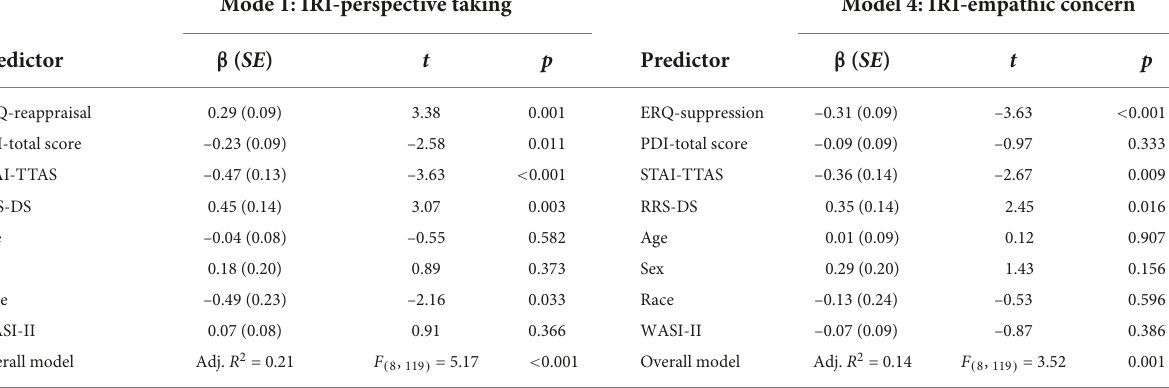
TABLE 3 Subset of linear models testing effects of emotion regulation strategies and delusion-proneness on empathic tendencies. Mode 1: IRI-perspective taking Model 4: IRI-empathic concern